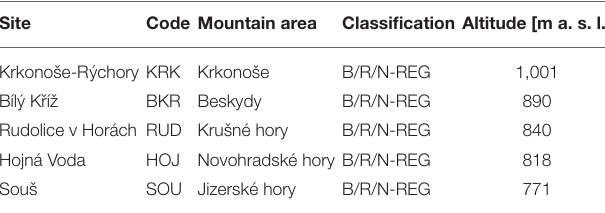
TABLE 1 | Measuring sites - basic characteristics. Site Code Mountain